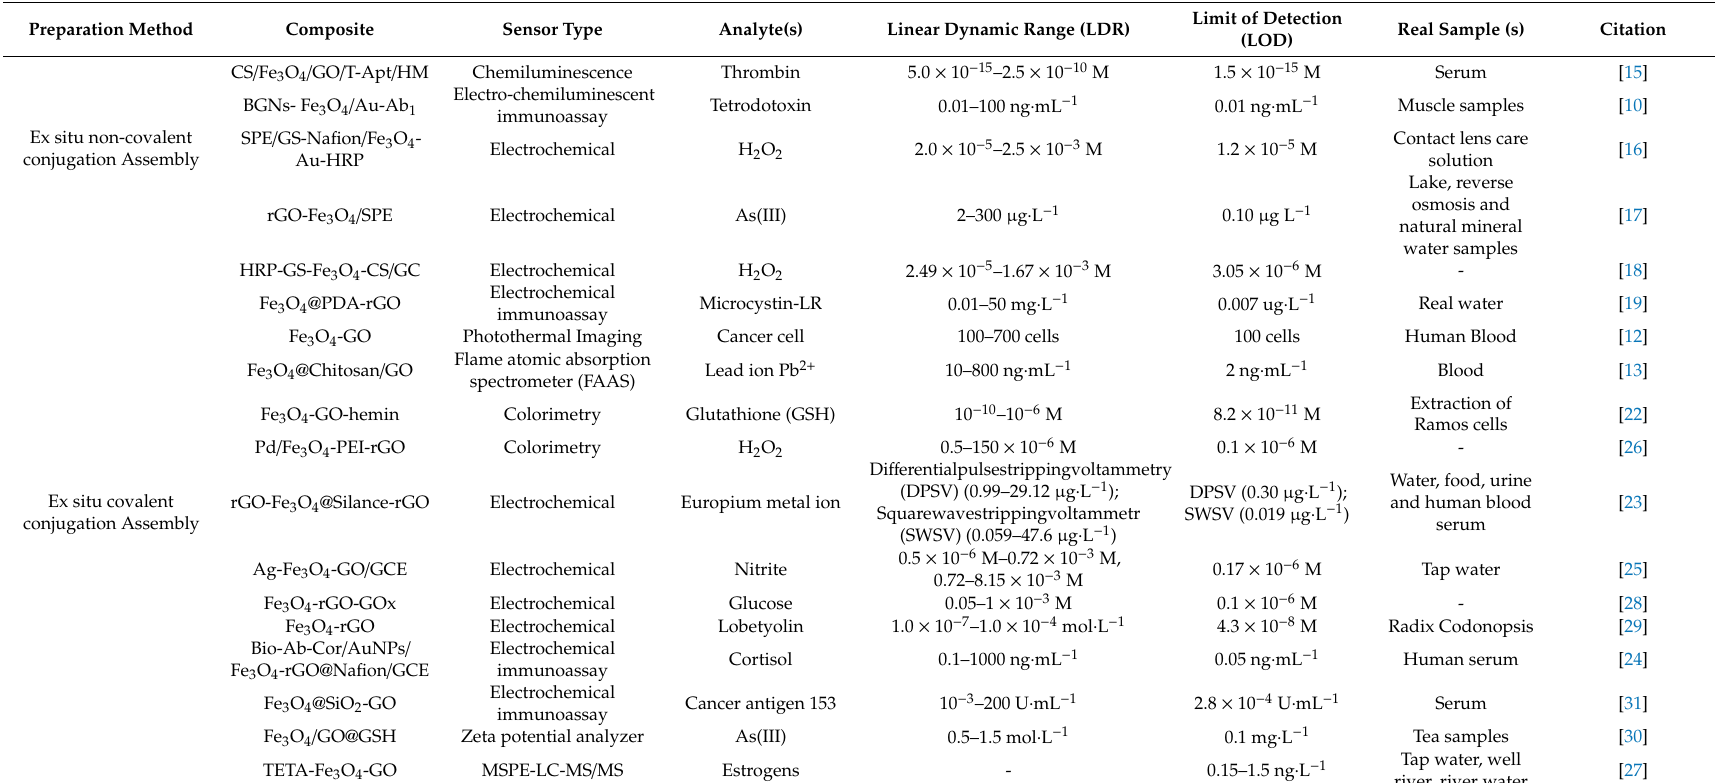
Table 1. Sensors based on the use of magnetic graphene